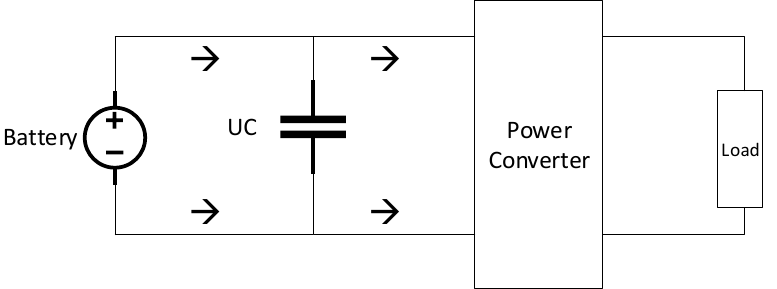
Figure 14. EV battery with ultracapacitor combined to provide power during high load demands. (Adapted from [17]).